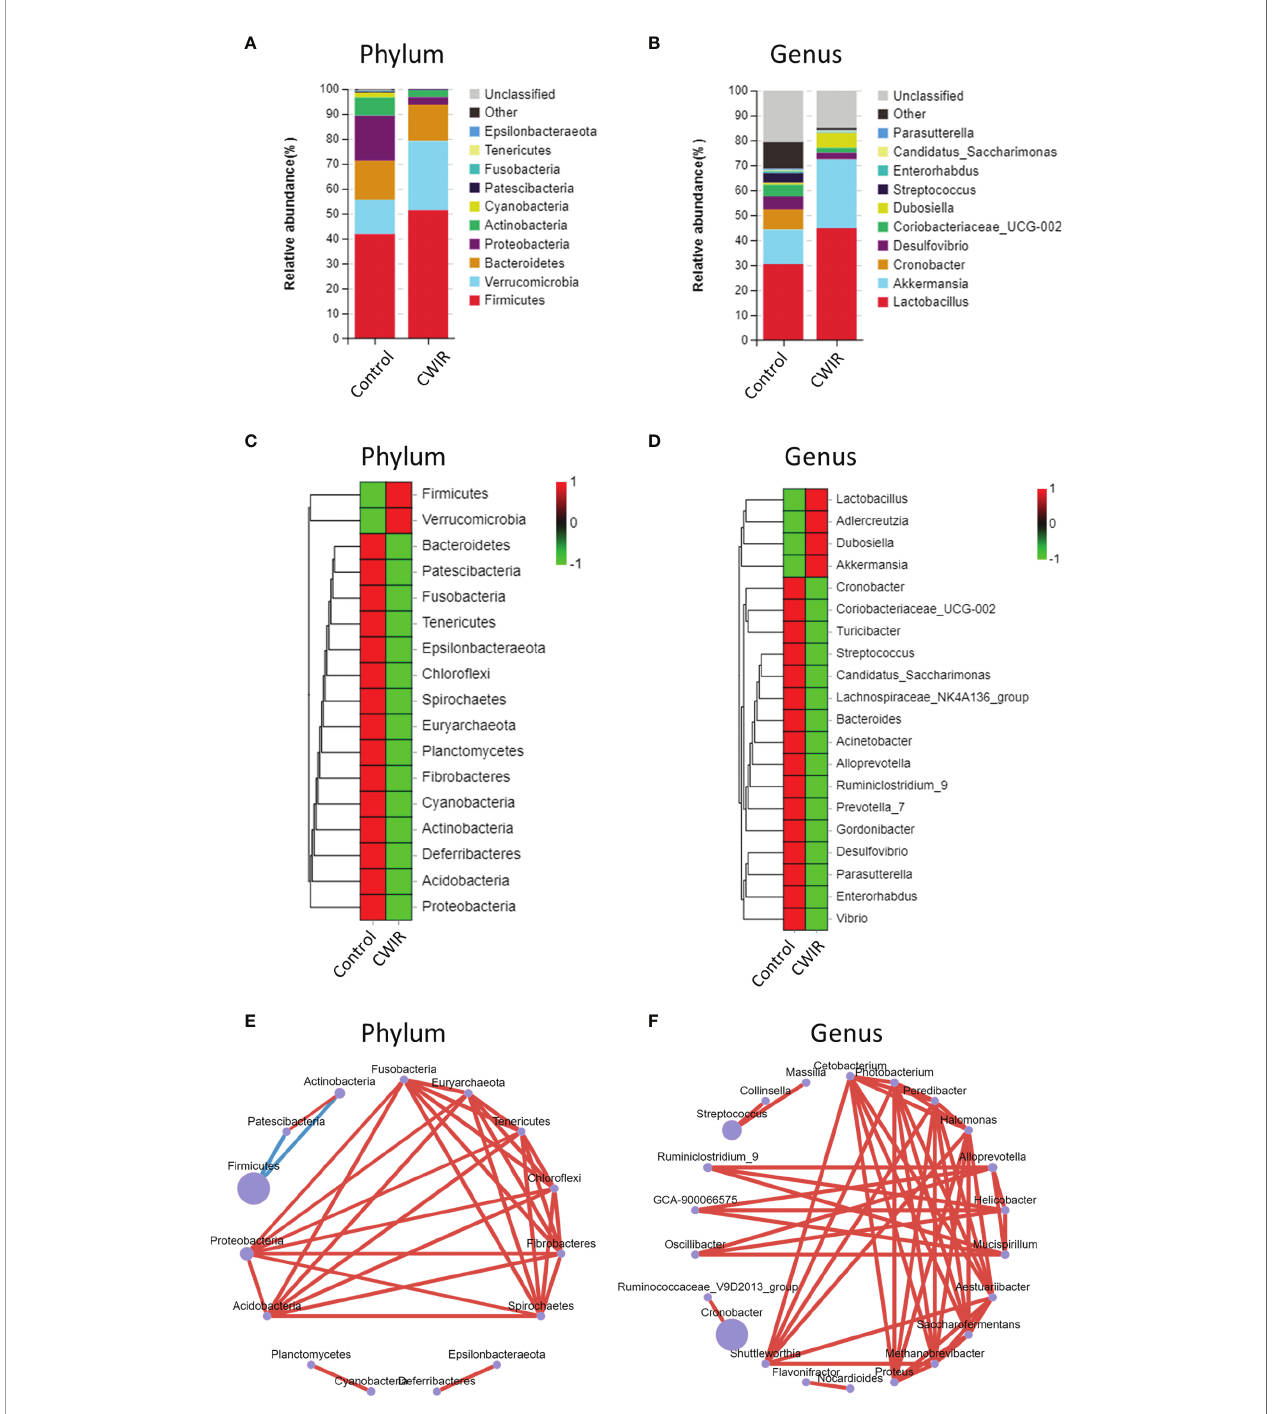
FIGURE 5 | Differences in relative abundance of bacterial fl ora. (A, B) Barplot analysis of the relative abundance in the fecal microbiota of control and CWIR mice at the phylum and genus level by average. Top 10 species in the mean abundance of all samples were shown in detail, other known species were classi fi ed as others, and unknown species were marked as unclassi fi ed. (C, D) Relative abundances of intestinal bacteria were clustered as a heatmap at the phylum and genus level. (E, F) Co-occurrence bacterial networks were established from 16S sequences from CWIR fecal samples based on the abundance table. Pearson correlation coef fi cient was calculated, and the network diagram was displayed at the phylum level and genus level. The size of each node is proportional to the relative abundance. The lines in red and blue denote positive and negative correlations, respectively. n = 4 per